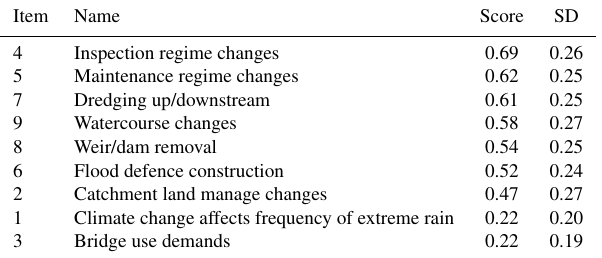
Table 5. Ranking scores for factors affecting change in scour vul-